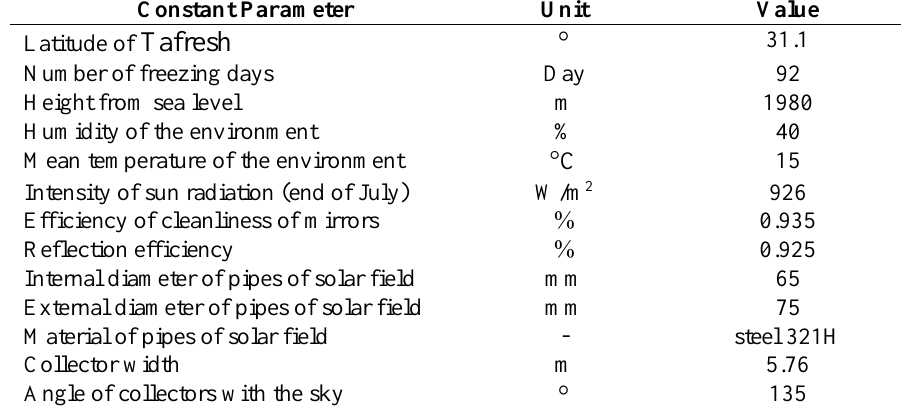
Table 1. Environmental conditions and design parameters